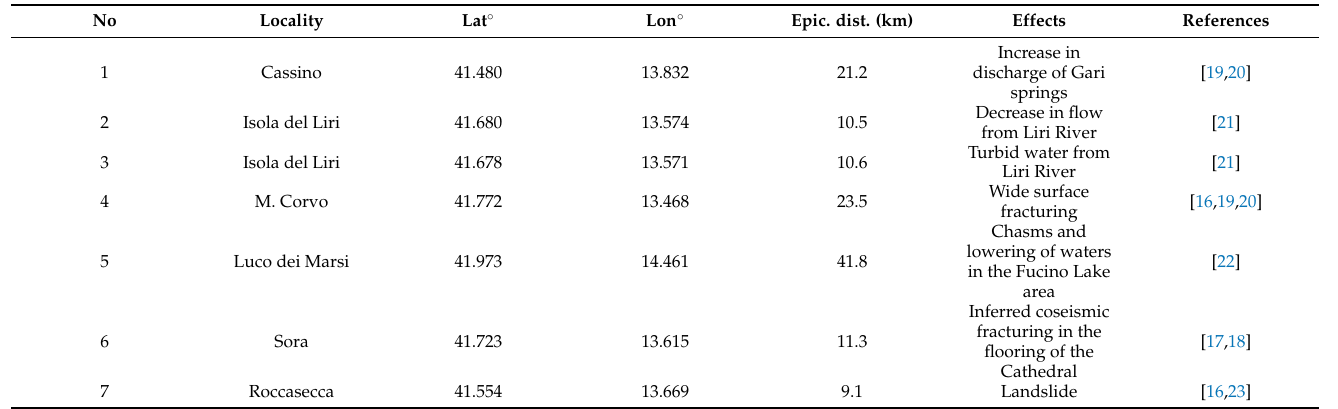
Figure 5. Distribution of the effects of the 1654 earthquake on the natural environment (see Table 1 and text for the description of the effects). Colored boxes are the modeled sources: BF, Balsorano fault; PF, Posta-Fibreno fault; SFa, Sora fault from ITHACA Working Group [12]; SFb, Sora fault from Boncio et al. [13]; MF, Macroseismic fault. Table 2. List of the effects observed in the natural environment following the 1654 earthquake (progressive number corresponds to Figure 5). The epicentral distance is calculated from the location of the Italian seismic Catalogue (red star in Figure 1) [5]